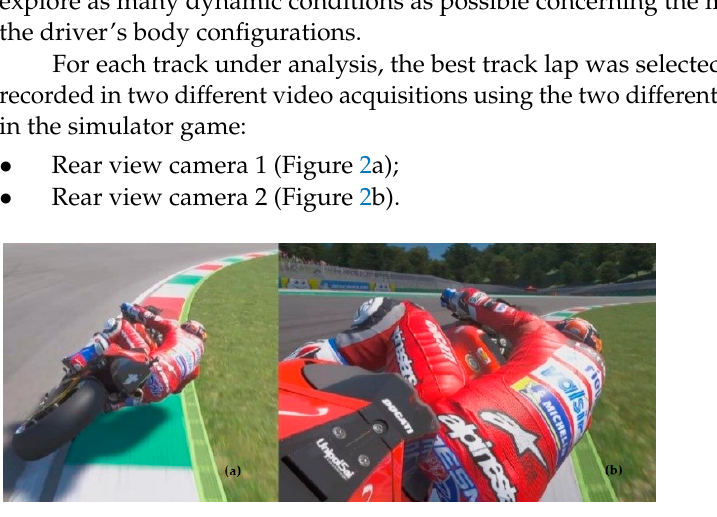
Figure 2. ( a ) Rear view camera 1; ( b ) rear view camera 2.